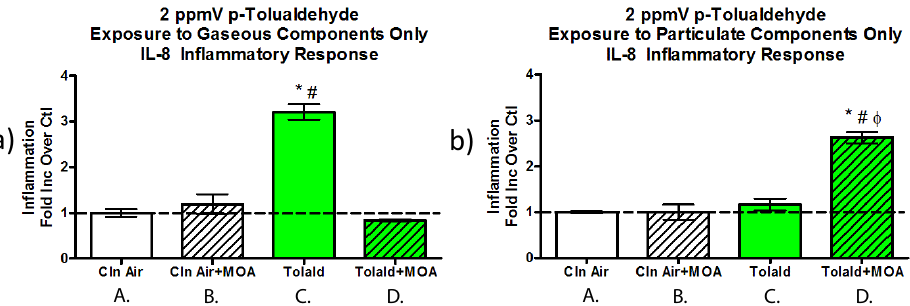
Fig. 4. The IL-8 inflammatory response of lung cells following exposure to four air mixtures. The response induced by exposure to (a) the gaseous components of each mixture and (b) the particle phase components of each mixture.